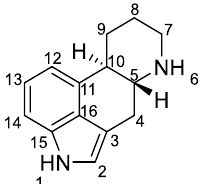
Figure 1. Structure of ergoline.